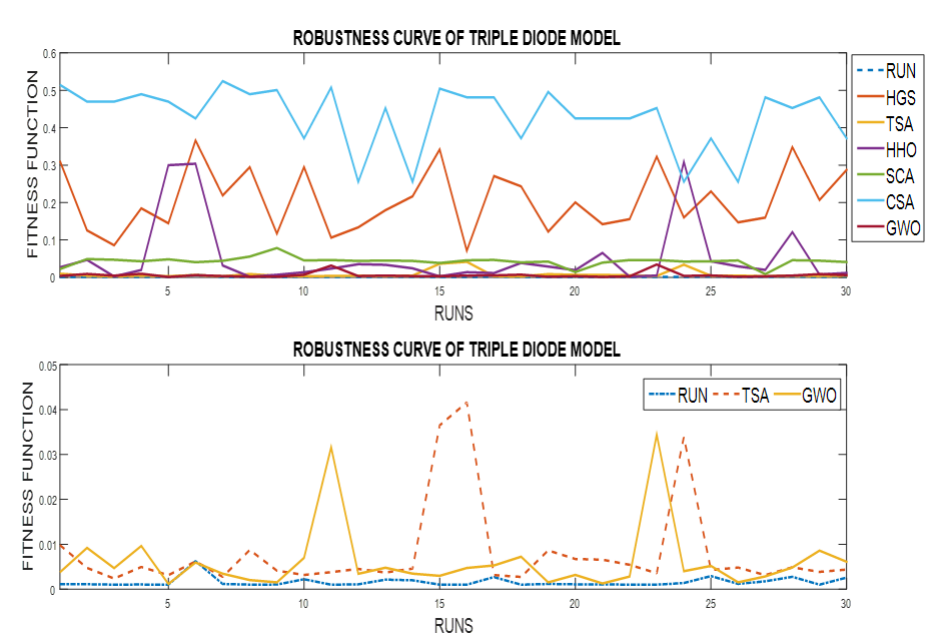
Figure 12. Robustness curve for